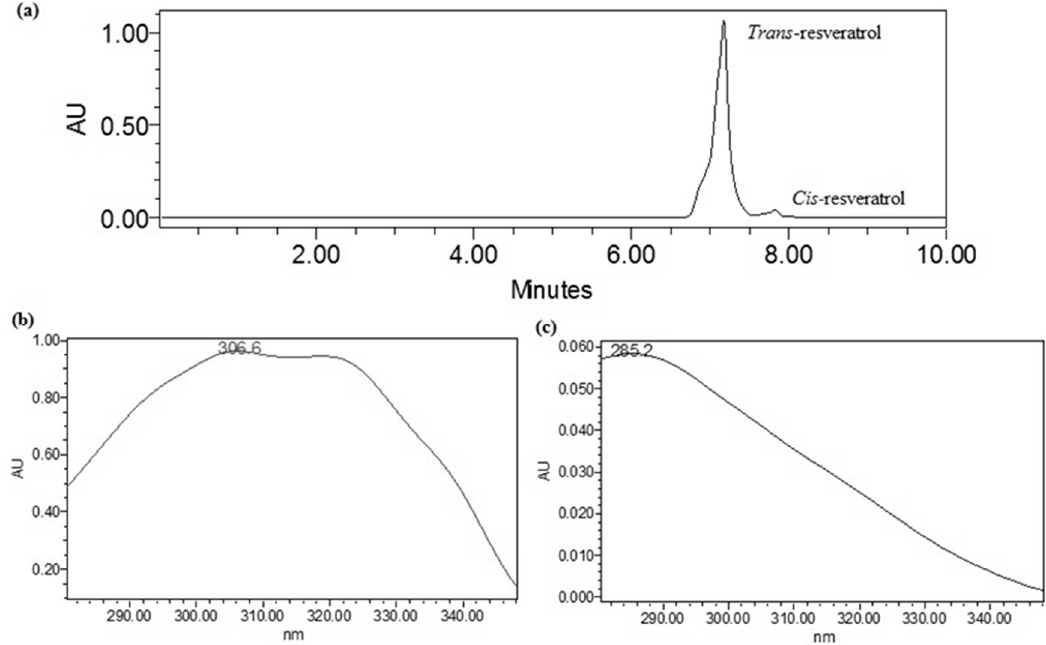
Figure 2. Retention times of trans - (7.194 min) and cis -resveratrol (7.847 min) in reverse-phase (RP)-HPLC chromatogram of standard solution of (50 µg/mL) after 1 h of exposition to UV light ( a ); UV absorption spectrum of trans -resveratrol ( b ) and cis -resveratrol ( c ) recorded in the range of 280–350 nm from the diode array.